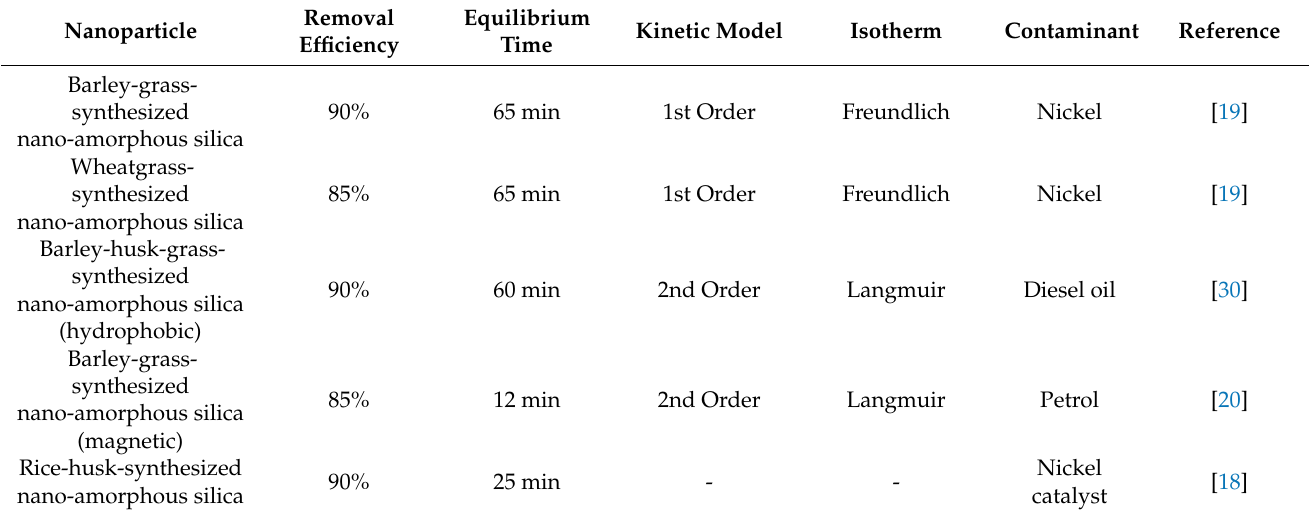
Table 3. Results from the applications of nano-silica particles from different sources.